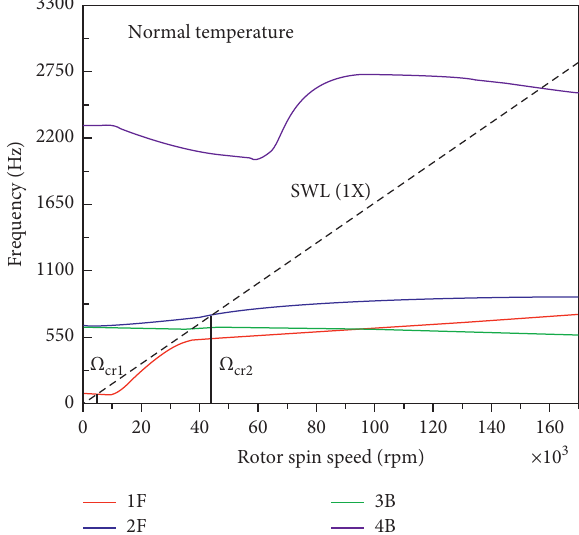
Figure 15: Campbell diagram showing whirl frequency and rotor-spin speed for the first four modes.